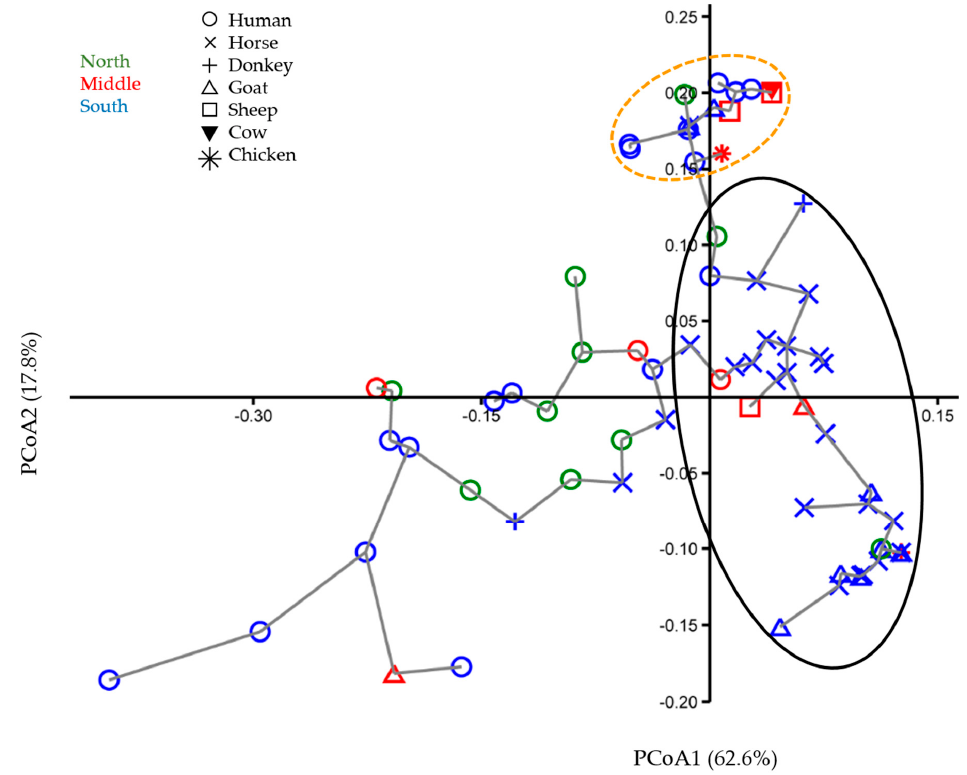
Figure 2. Principle coordinates analysis plot (principal coordinate 1 vs. principal coordinate 2; combined percent variance explained = 80%), with minimum spanning tree, computed on the identity matrix for animal handler and animal TTV isolates’ 5 ′ -UTR sequences. The geographical locations of isolates are in different colors. Isolates from different host species are represented by different symbols.